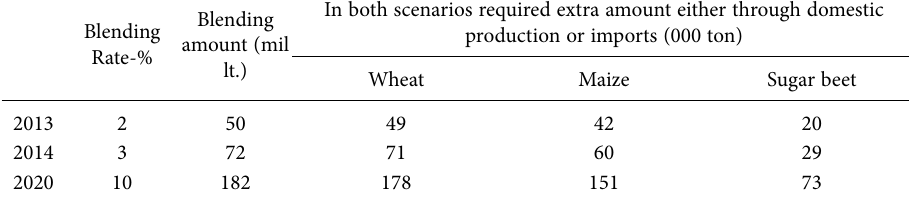
Table 3. Required